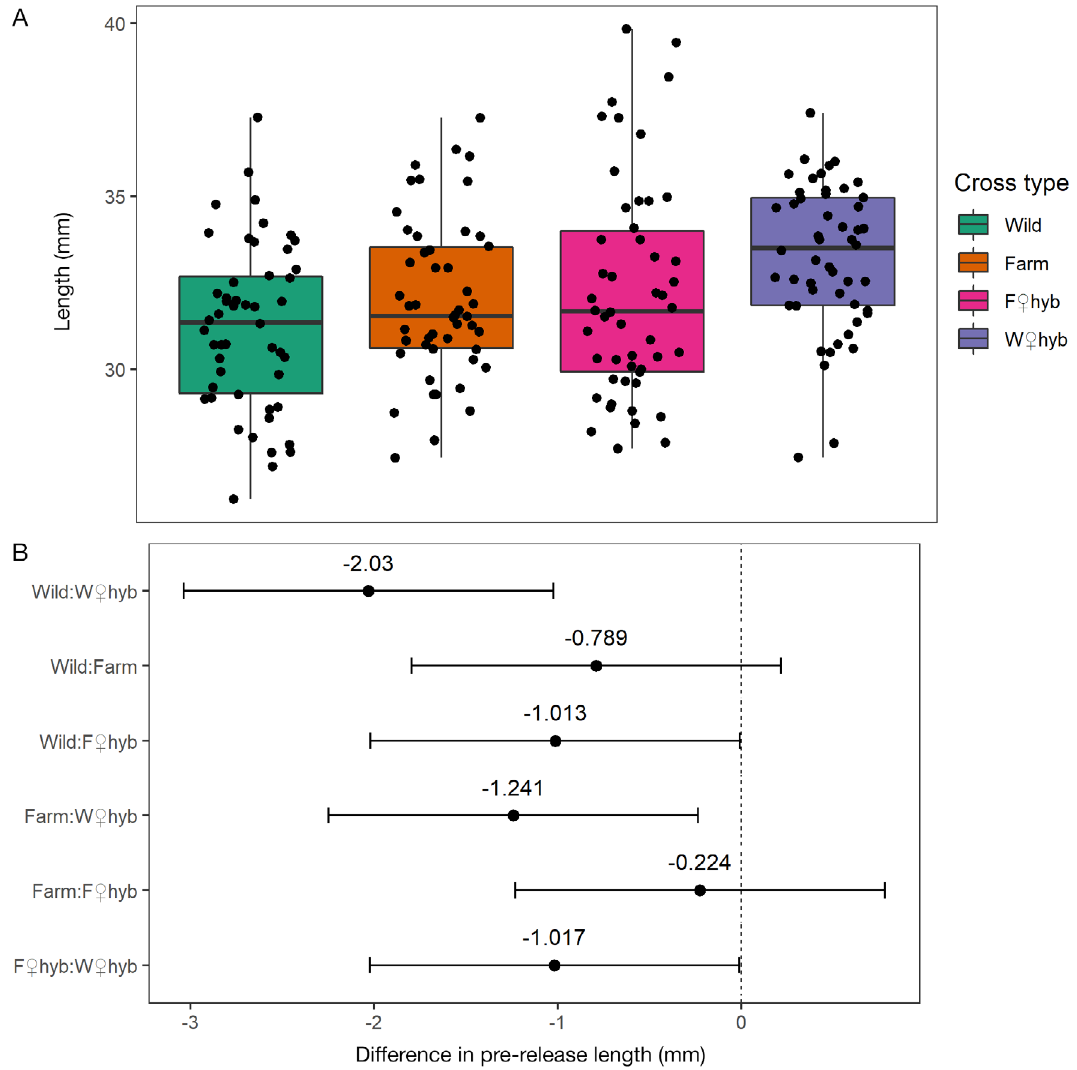
Fig. 4. (A) Boxplots of Atlantic salmon release length × cross type. Lines in boxplots represent median value, upper and lower hinges represent third and first quartiles (respectively), and upper and lower whiskers extend to furthest value no more than 1.5 times the inter-quartile range above and below the upper and lower hinges (respectively). (B) Pairwise differences in mean release length for all cross types. Error bars on pairwise differences represent ±2 SE of the difference